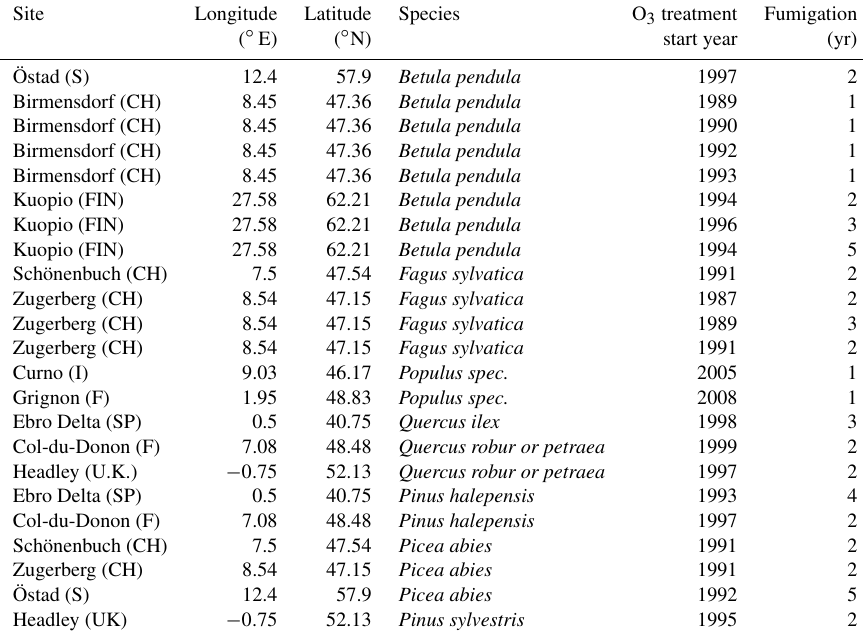
Table A2. List of fumigation experiments used by Büker et al. (2015) and simulated